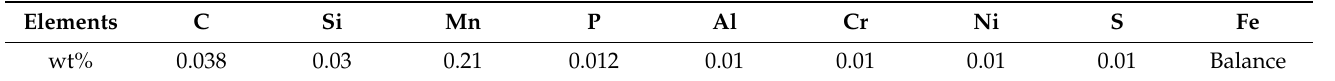
Table 1. Chemical composition of the HPB235 round steel